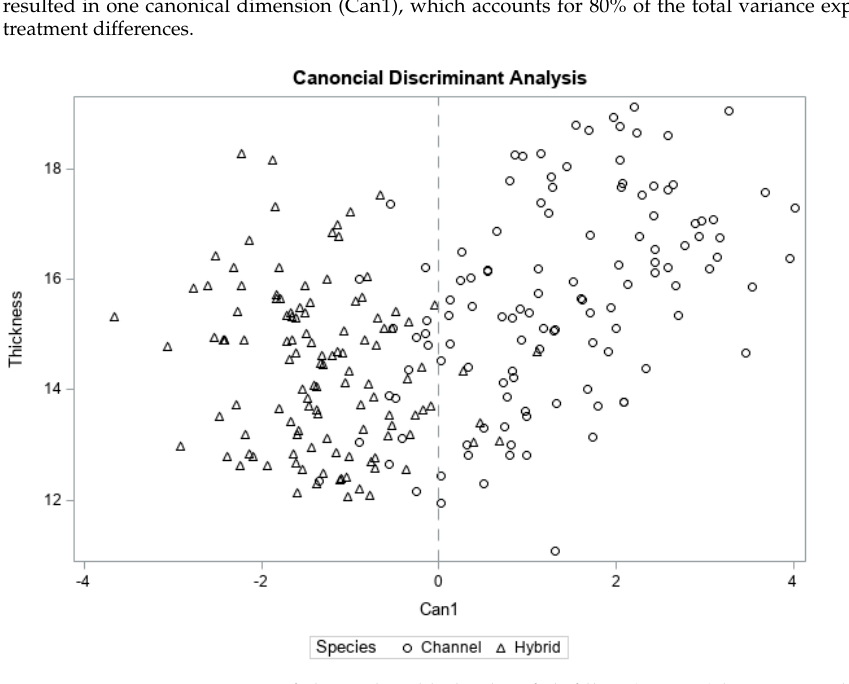
Figure 3. Group separation of channel and hybrid catfish fillets ( n = 119) by TPA attributes. Because the variable catfish − type had two levels (channel and hybrid), the canonical discriminant analysis resulted in one canonical dimension (Can1) which accounts for 80% of the total variance explaining overall treatment differences. Table 6. Proportion of correct classifications (channel or hybrid; n-119) based on